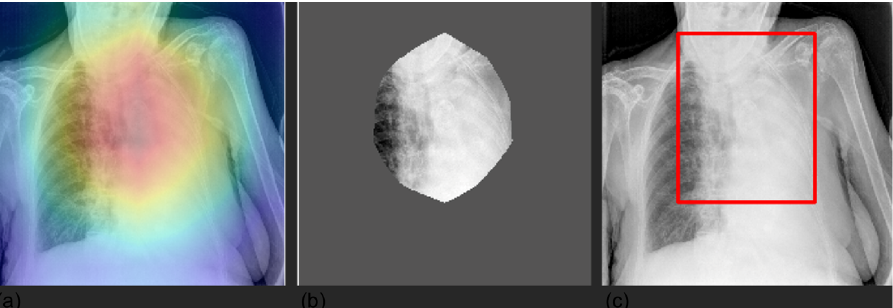
Figure 7. Visualization of lung prediction maps for a selected CXR. The panels represent the saliency mask obtained with Grad-CAM (panel a ), the relevant area (mask values higher than the 0.8 quantile) (panel b ), and the respective bounding box (panel c ). The saliency mask, as emphasized by the heat map (panel a ), focuses on the left lung, which shows lung abnormality.